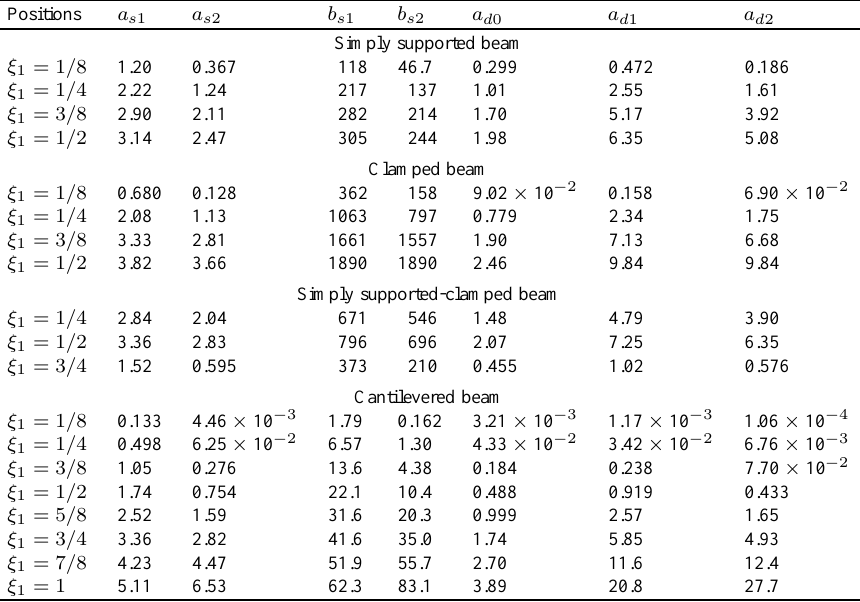
Table 4 The mass and stiffness factors of a beam with a concentrated